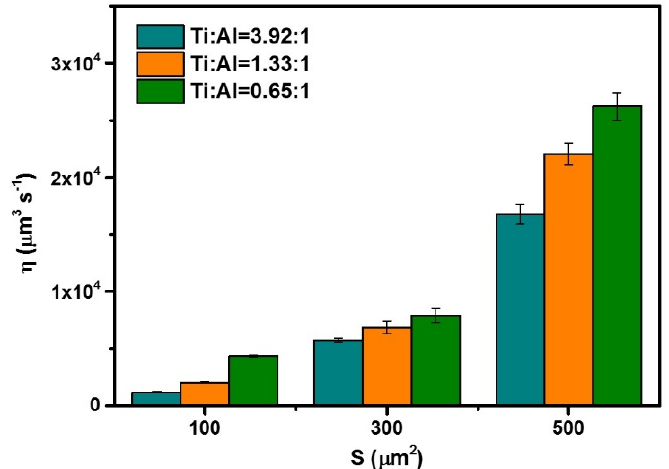
Figure 5. Water collection efficiency of the MHHFs at different ratios of Ti and Al (the error bars indicate the standard deviations of the